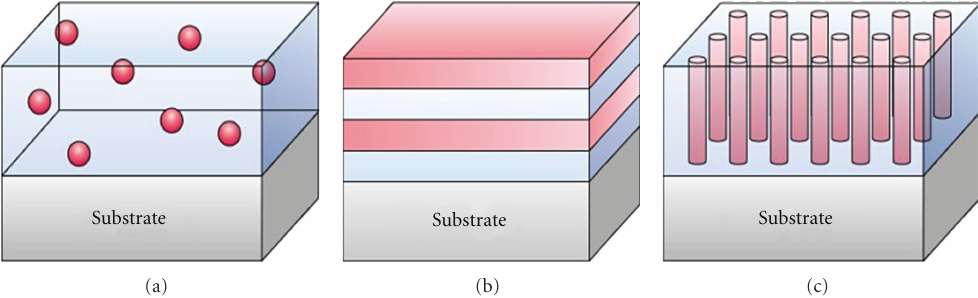
Figure 4: Schematic illustration of three ME composite films with the three common connectivity schemes: (a) 0-3 particulate composite, (b) 2-2 laminate composite, and (c) 1-3 fiber/rod composite films, [2]. Table 3: Summary of advantages/disadvantages of ME composite films with di ff erent connectivity. Connectivity Advantage Disadvantage